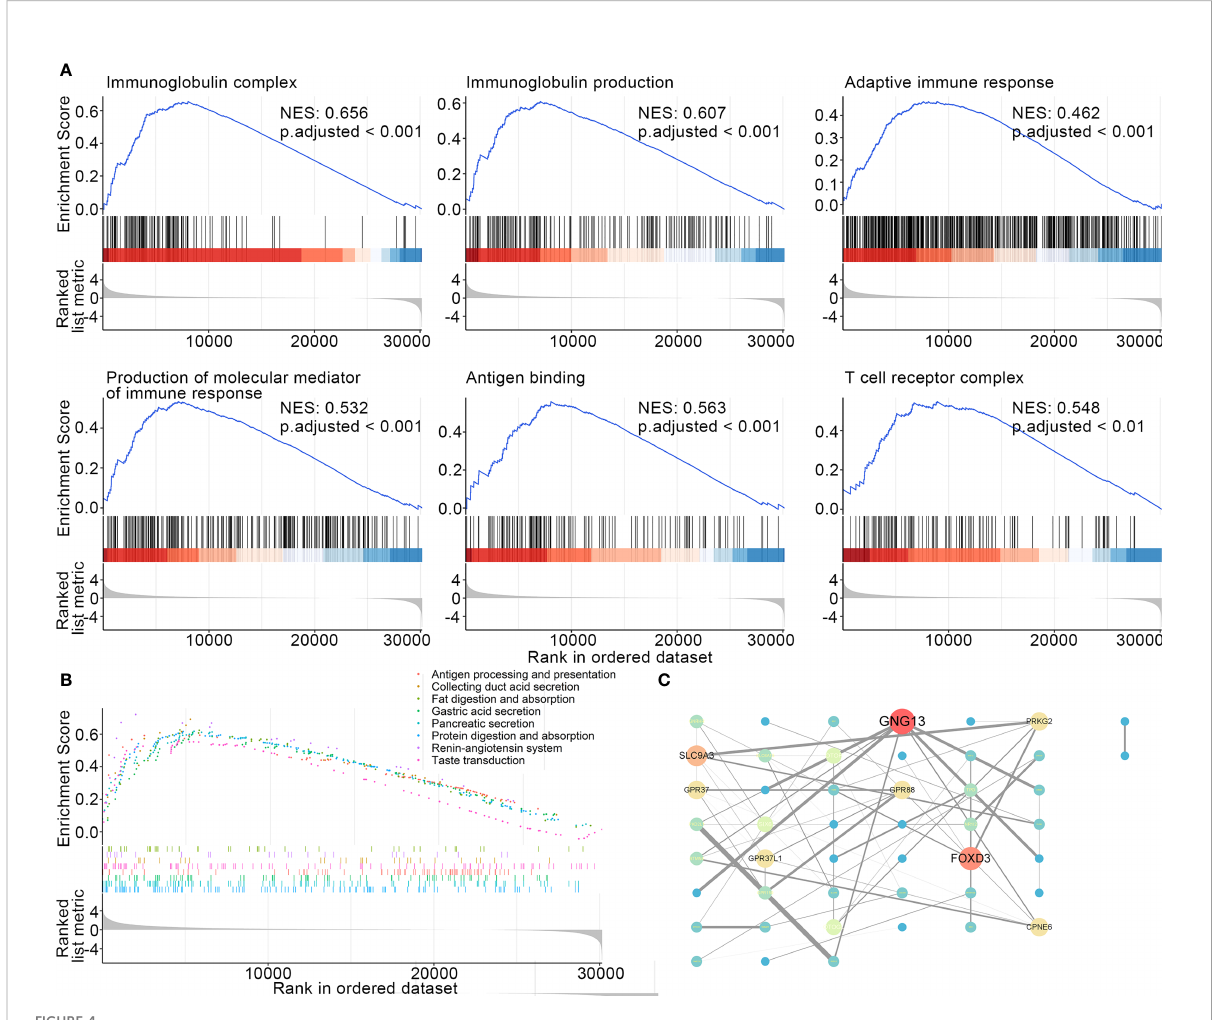
FIGURE 4 Dissecting underlying mechanisms leading to different outcomes. (A) Resultant data of GSEA (BP, CC, MF). (B) GSEA results (signaling pathways). (C) Protein-protein interaction